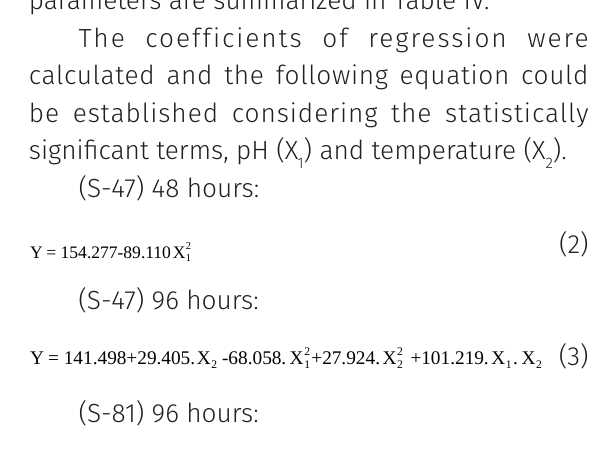
Table II. Production of reducing sugars (mg.L -1 ) by Candida homilentoma strains using Central Composite Rotatable Design